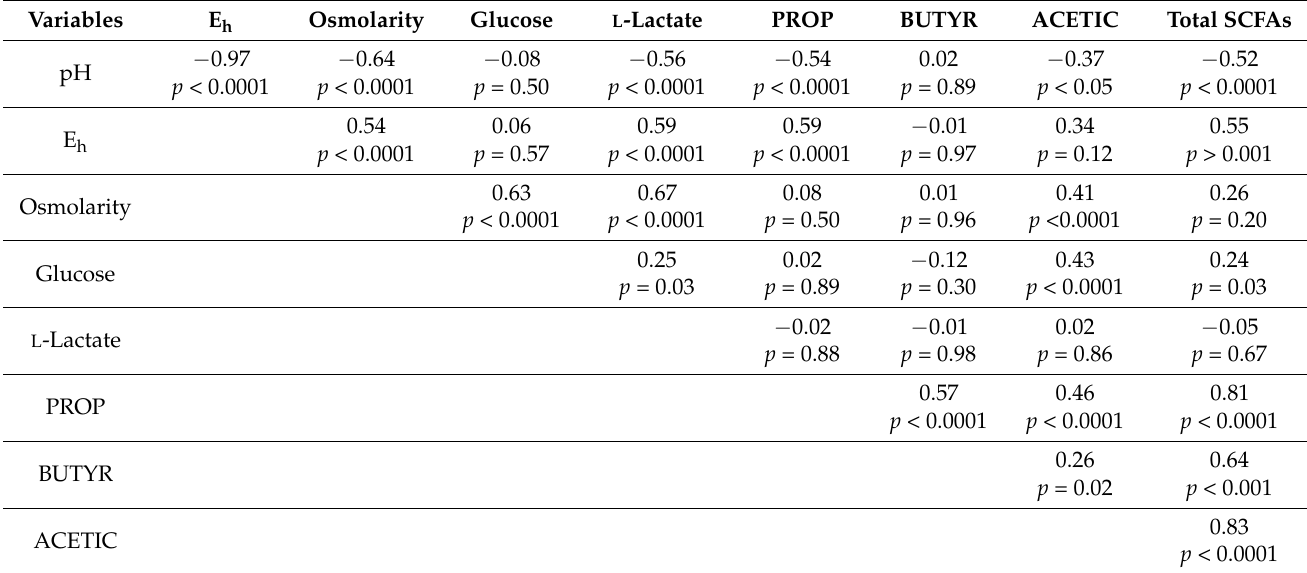
Table 2. Correlation between pairs of ruminal variables in beef heifers submitted to experimental induction of subacute ruminal